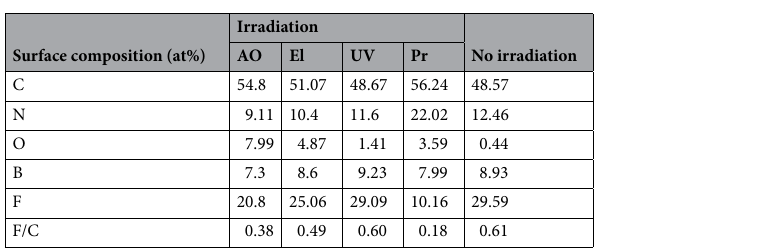
Table 2. The surface compositions (at.%) of ILs after irradiation by XPS.